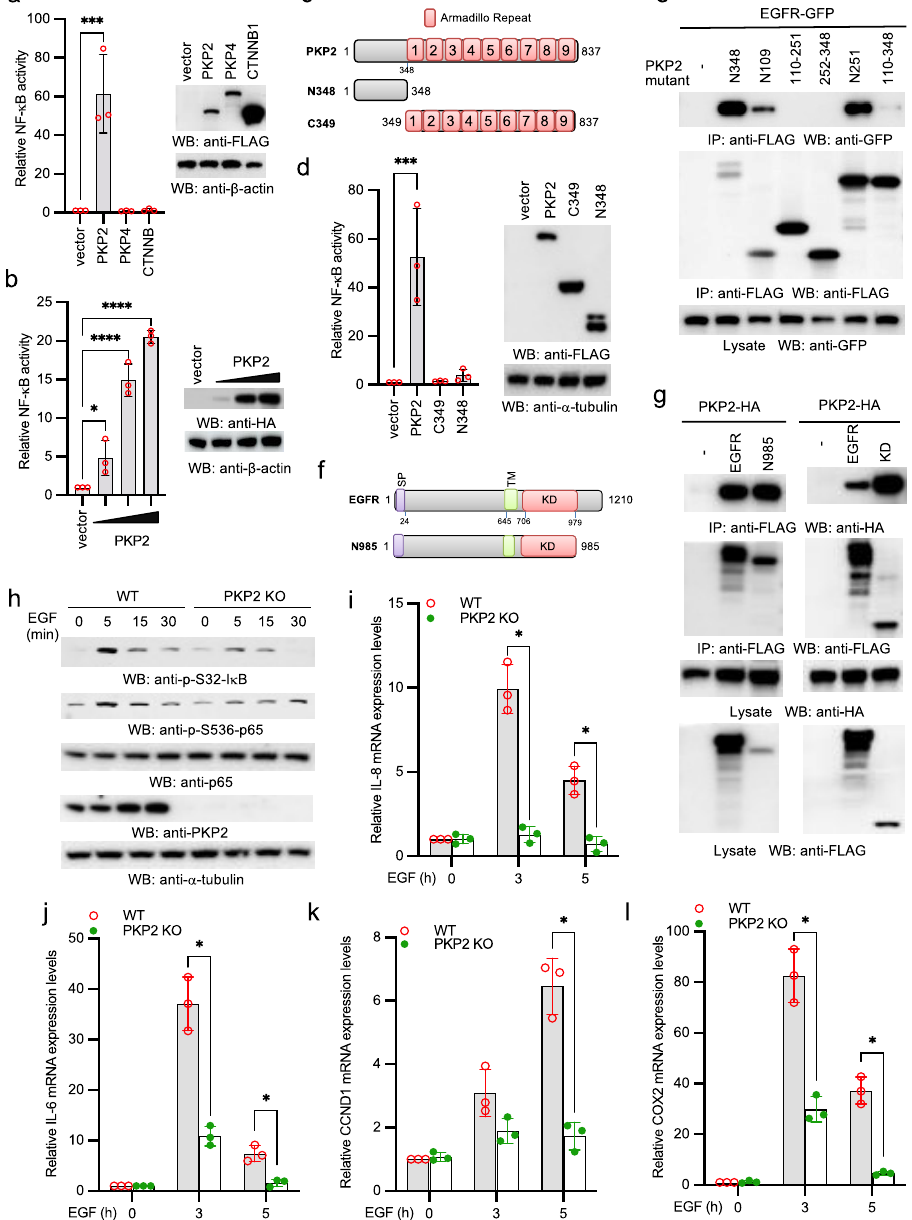
Figure 1. PKP2 is required for EGFR-induced NF- κB signaling. ( a ) FLAG-tagged PKP2, PKP4, or CTNNB1 was transfected with pRL-SV40 (Renilla luciferase as an internal control) and NF- κB -Luc into HEK293 cells. After 48 h, cells were collected, and the ratio of firefly luciferase to Renilla luciferase was calculated to determine the relative reporter activity. Right panel shows protein expression levels by Western blotting. ( b ) Different doses of PKP2 were transfected with pRL-SV40 and NF- κ B-Luc into HEK293 cells. After 48 h, cells were collected, and the ratio of firefly luciferase to Renilla luciferase was calculated to determine the relative reporter activity. Right panel shows protein expression levels by western blotting. ( c ) Schematics of PKP2 mutants. ( d ) PKP2 or the indicated